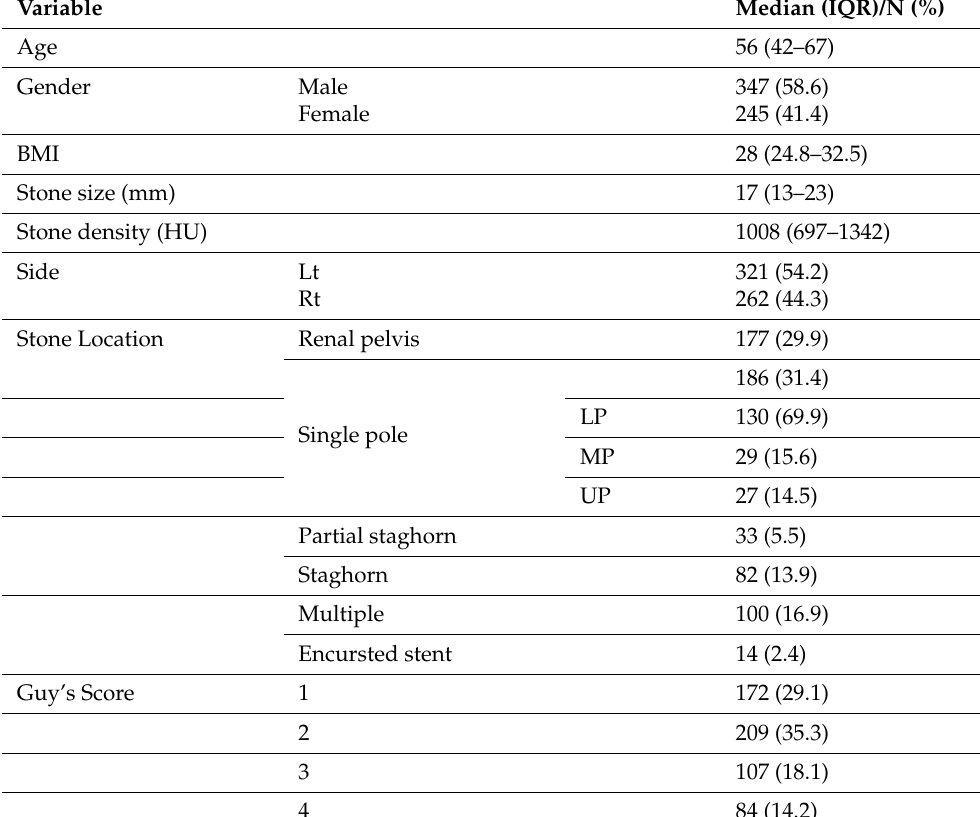
Table 1. Clinicopathological features for 592 patients who underwent supine